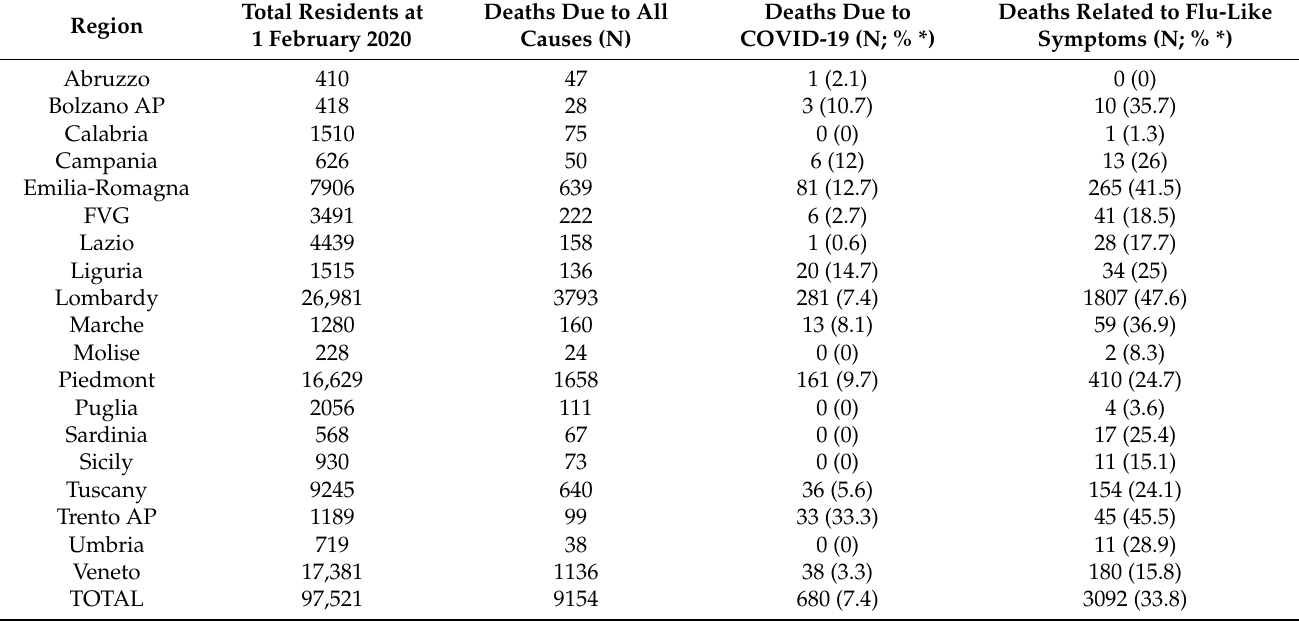
Table 3. Total of residents in nursing homes involved in the survey on 1 February 2020, total deaths due to all causes, total deaths due to confirmed COVID-19 and total deaths in subjects with flu-like symptoms since 1 February 2020 (modified from